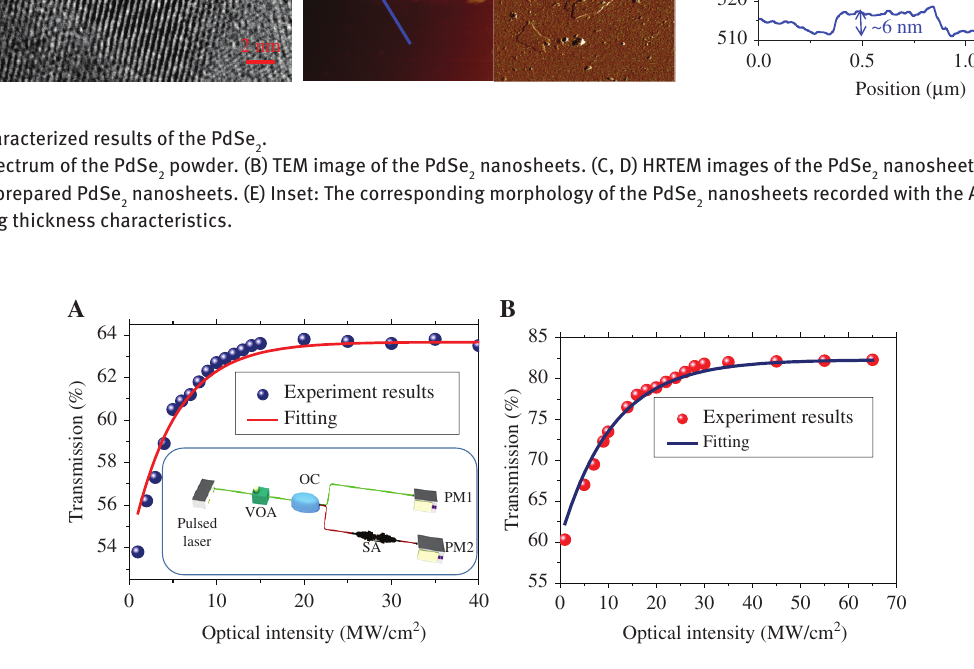
Figure 5: Nonlinear optical absorption properties of the PdSe (A) Within 1- μ m region. (B) Within 1.5- μ m region. (A) Inset: The experimental setup used for testing nonlinear optical